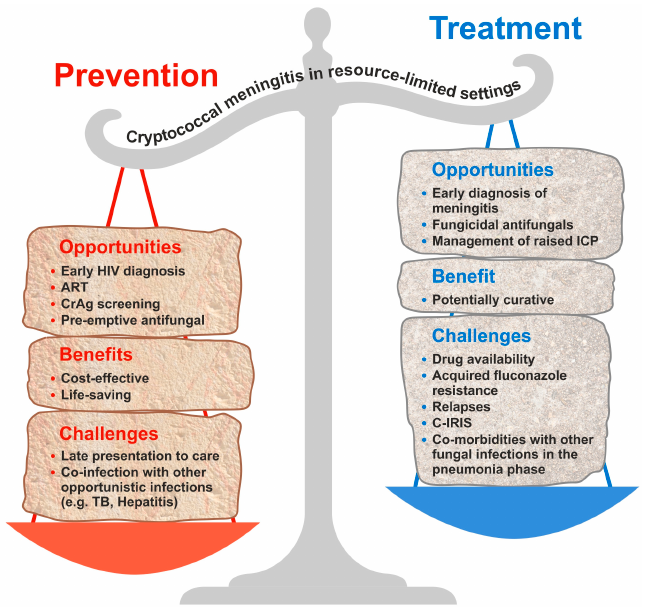
Figure 4. Opportunities, benefits and challenges of prevention and treatment of cryptococcosis in resource limited settings. C-IRIS. Cryptococcal-Immune reconstitution inflammatory syndrome. TB. Tuberculosis. ART. Anti-retroviral therapy. CrAg. Cryptococcal antigen. ICP. Intracranial pressure.